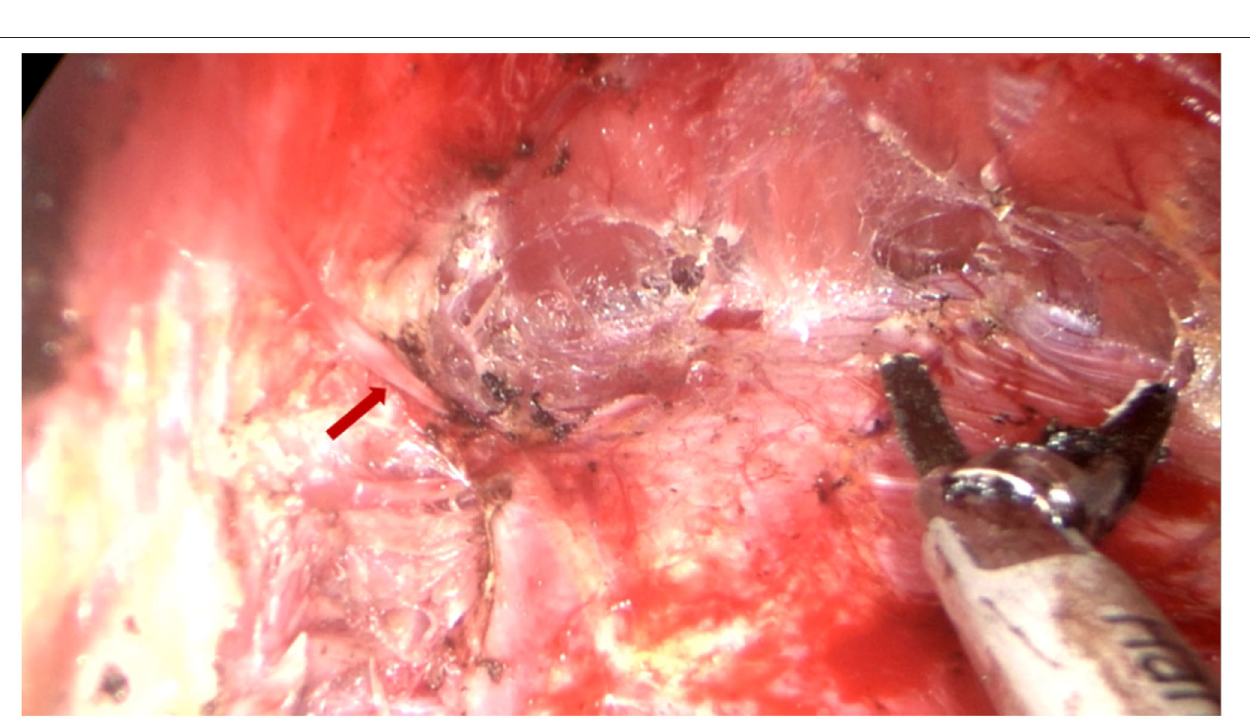
FIGURE 2 | Dissecting the lateral pocket during endoscopic transaxillary breast augmentation. Near the anterior axillary line of the upper border of the fifth costal, the fourth intercostal anterior skin branch (indicated by the red arrow) can be clearly observed under the endoscope, which needs to be carefully retained.